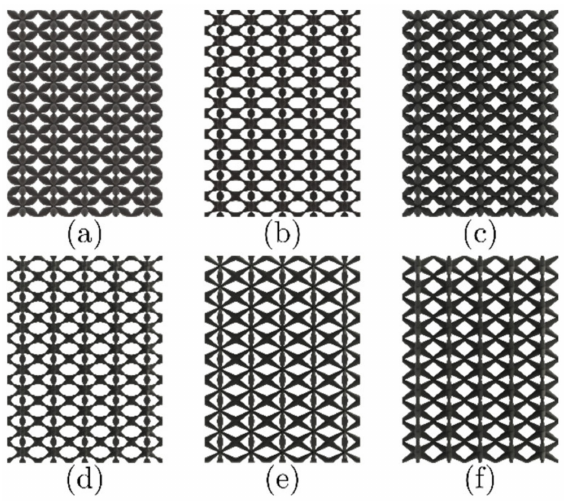
Figure 4. Lattice structures with cross-section variation of the strut. Type of variation ( a ) COS,